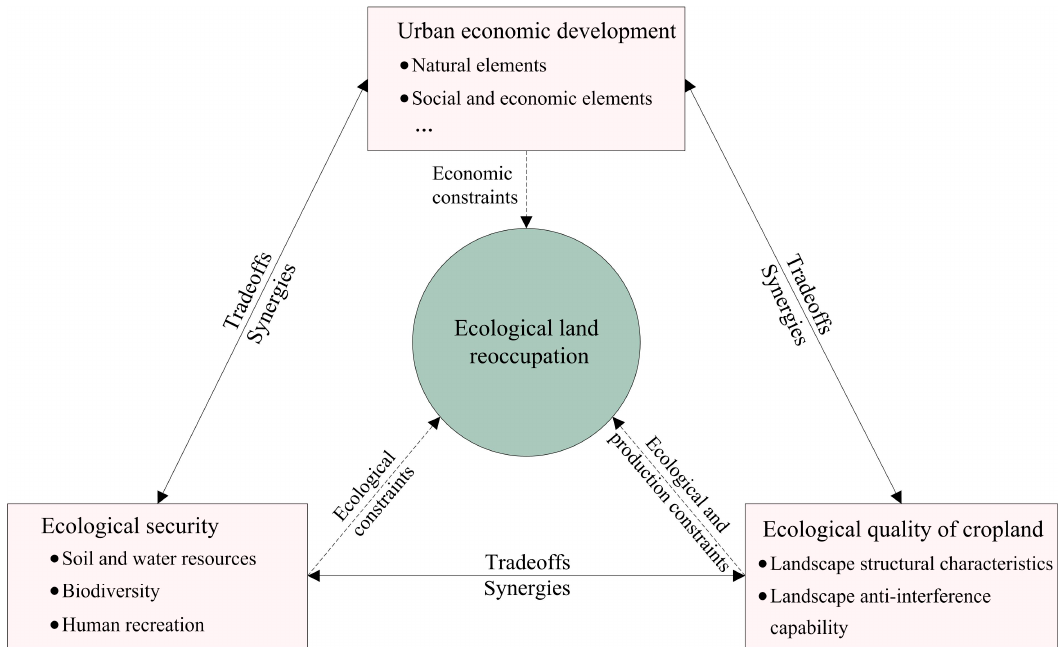
Figure 2. Theoretical framework of the ecological land optimization trade-offs.